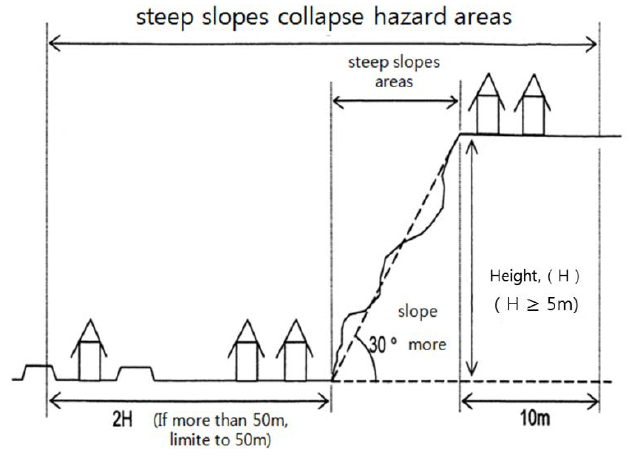
Figure 2. Sectional view of criteria of steep collapse hazard zones [10]. Source: Ministry of Land, Infrastructure and Transport Infrastructure Development Institute, Japan. (http://www.mlit.go.jp/ sogoseisaku/inter/keizai/gijyutu/pdf/sediment_e.pdf).